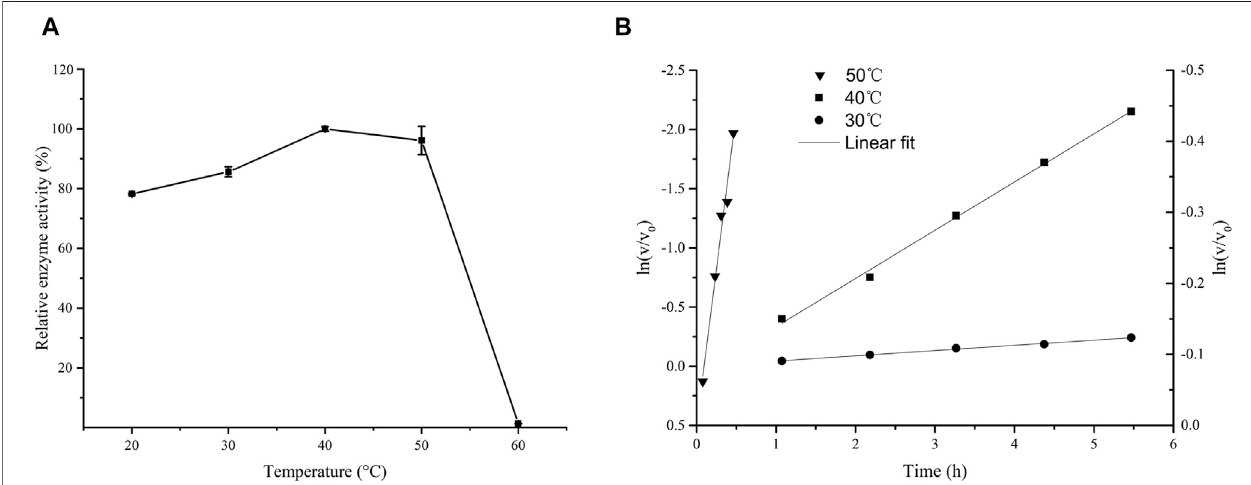
FIGURE1 | Effect oftemperature on the activity of Lsa AS-A. (A) Optimaltemperature of Lsa AS-A. (B) Plot ofthe fi rst-order exponential decay formula to show the thermal stability of Lsa AS-A at 30, 40 and 50 ° C. The calculated values of the ln at 30 ° C and 40 ° C were calibrated by the left ordinate, while the counterpart at 50 ° C was calibrate by the right ordinate.